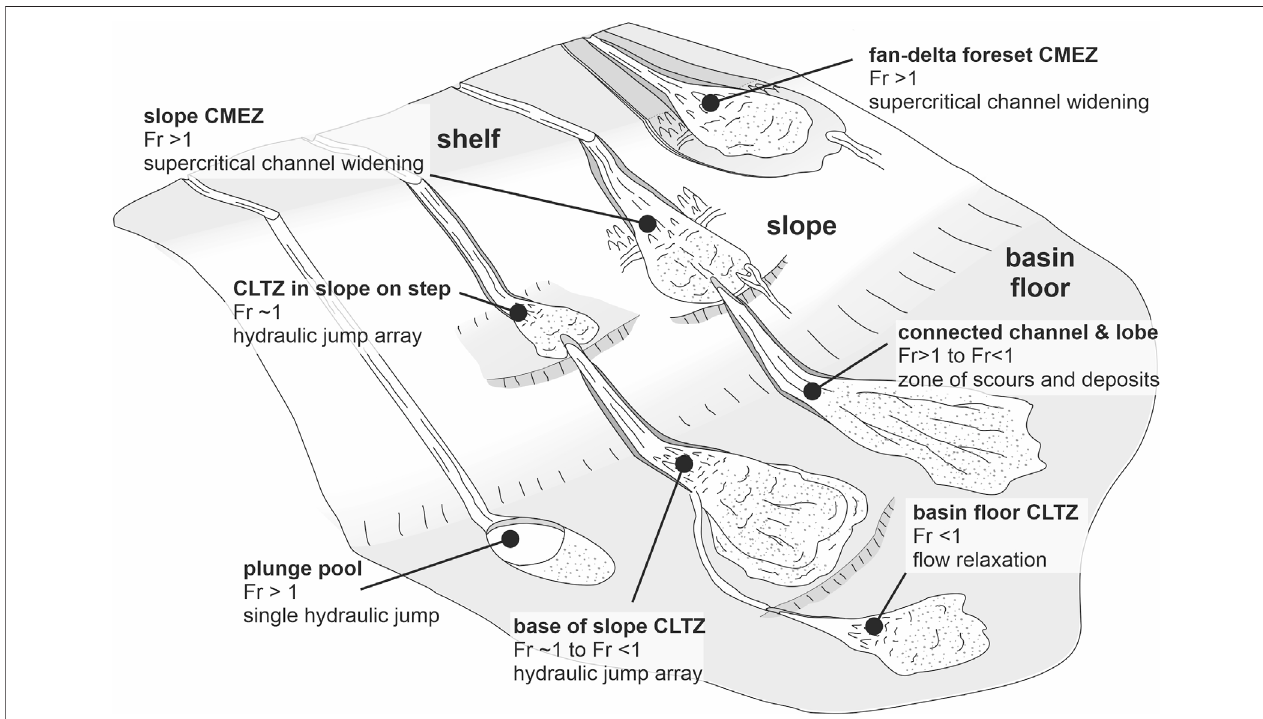
FIGURE11| Asynthesis ofdifferenttypes ofchannel mouth settings, their likelyphysiographic location, and dominant fl ow type interms of fl ow criticality. Channel mouth expansionzones (CMEZs)arepresent onsteepslopes,includingforesetsoffandeltas,and aredominated bysupercritical fl owsand bedforms. Plungepoolsare located at the base of steep slopes forming a single hydraulic jump, and with fl ow having supercritical Froude numbers. Note that plunge pools can also form within canyons where they are related to features such as knickpoints. Channel-lobe transition zones (CLTZs) with hydraulic jump arrays form at breaks-of-slope, with supercritical fl ows closer to unity. Subcritical CLTZs associated with fl ow relaxation, typically form in relatively distal locations at points of fl ow expansion. Channels and lobes can also be connected, without a transition zone developing, at the base of slope with mixed erosional and depositional